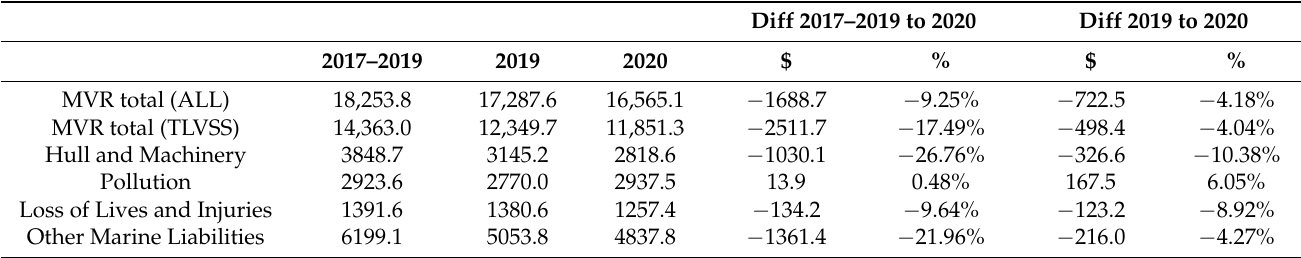
Table 5. Difference in MVR due to pandemic, in million USD.